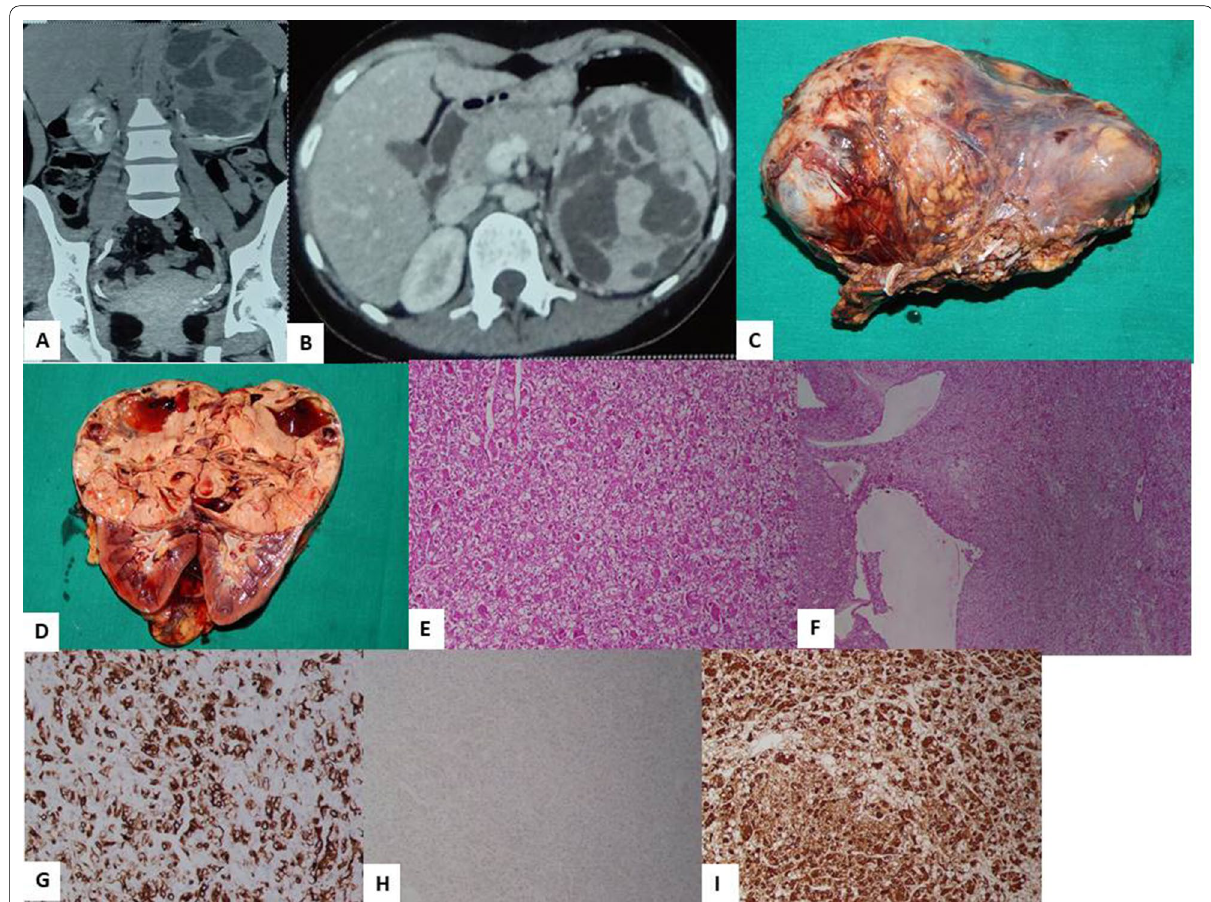
Fig. 1 A , B A large, well-defined, exophytic, heterogeneous, multiloculated, cystic lesion arising from upper pole of left kidney—9.4 * 8 * 11 cm size, showing thick heterogeneously enhancing internal septations and discrete foci of peripheral wall calcifications causing splaying of renal calyces with increased paralesional vascularity. C , D 15 * 9 * 7 cm specimen, 547 gm, left upper pole and mid pole tumor 9.5 * 8 * 8 cm, unifocal with cystic and hemorrhagic areas within E eosinophilic cells with solid and areas. F Section shoes tumor composed of solid and custic areas. G CK 20 positive. H CK 7 negative. I SDH B